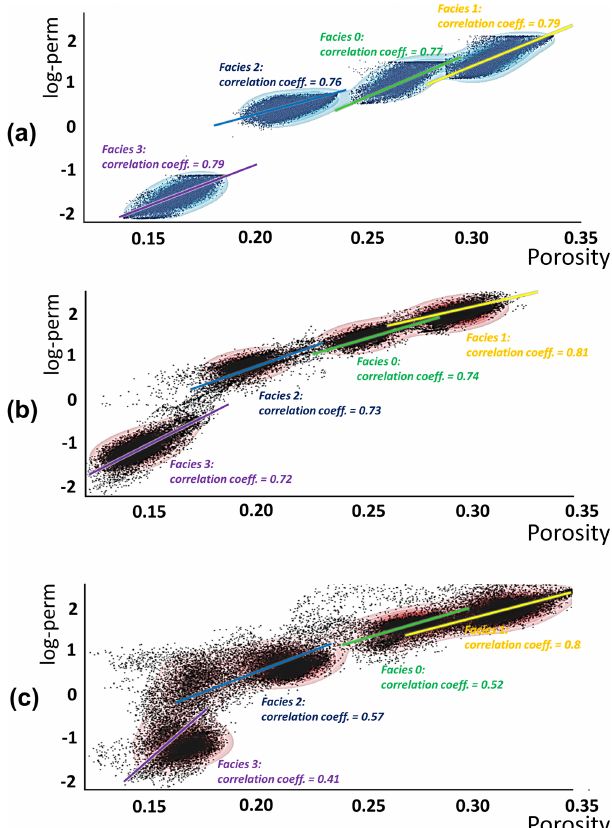
Figure 20. Bivariate distribution between porosity and log-perm model of realization no. 1 (a) prior, (b) posterior from the sequential decomposition, (c) posterior without performing sequential decom- position. The correlation coefficient is examined for each facies.